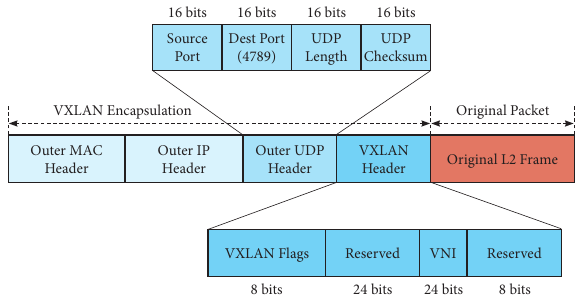
Figure 2. VXLAN Packet